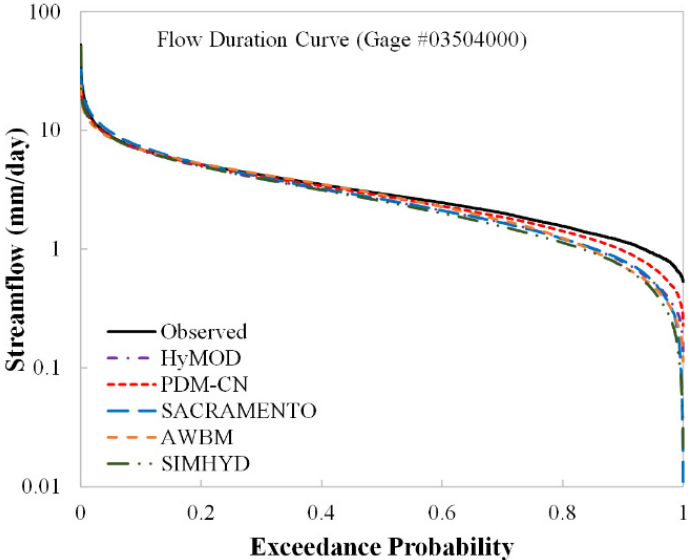
Figure 9. Observed and simulated flow duration curves during the validation period (1974–2003) for the Nantahala River in North Carolina.